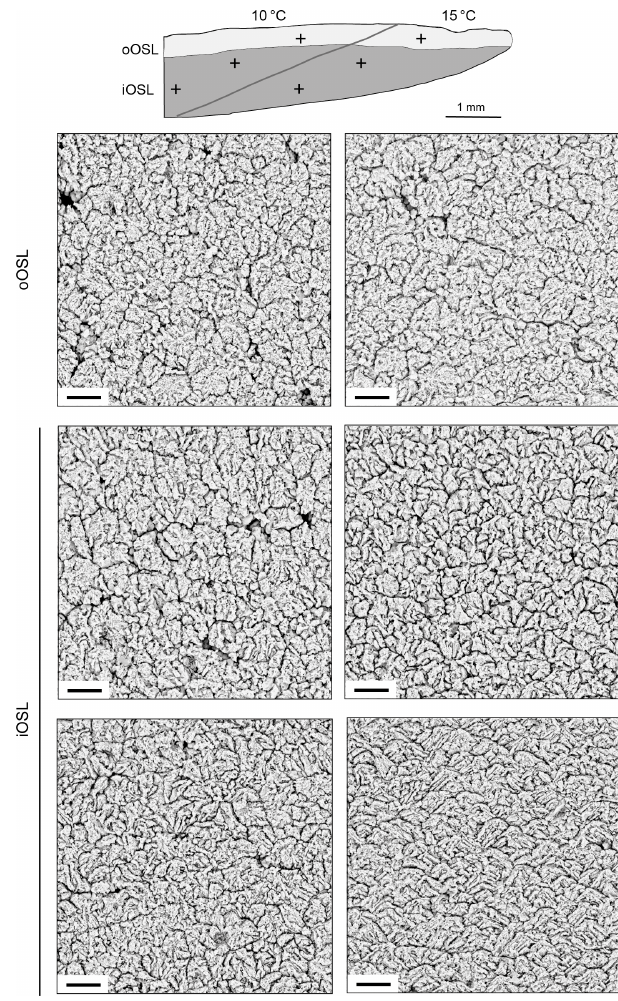
Figure 6. SEM images of Arctica islandica shell microstructures formed at 10 ◦ C (left column) and at 15 ◦ C (right column). The sketch indicates the position of the images 1mm away from the cal- cein mark (gray line). The first row of images refers to the oOSL, the other two row refers to the iOSL. Scale bars if not otherwise indicated =